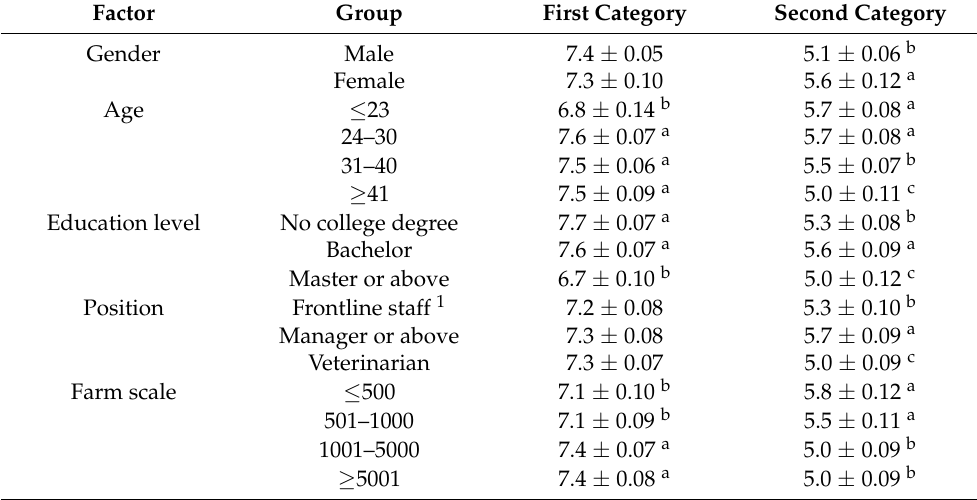
Table 4. Pain score (least squares means ± standard error) of two condition categories characterised by severe pain with low variability and less severe pain with high variability,